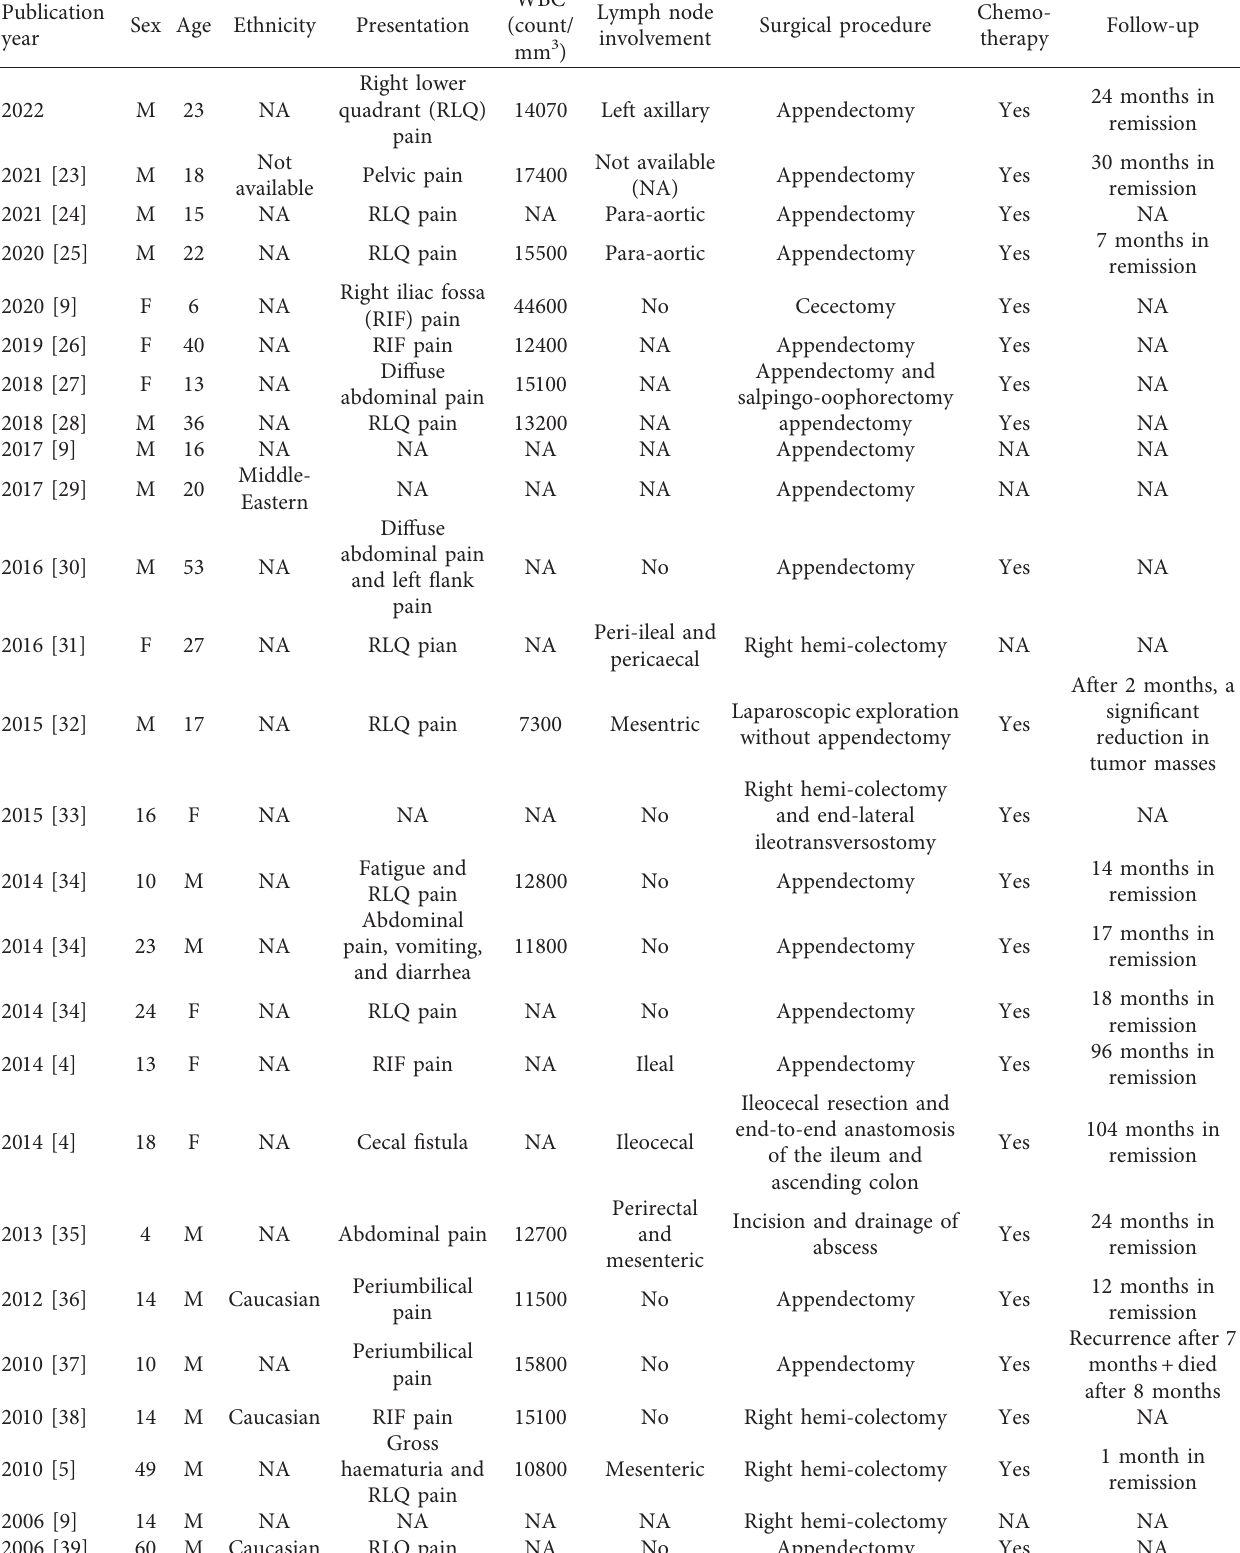
Table 1: Characteristics of Burkett’s lymphomas mimicking appendicitis as reported in the